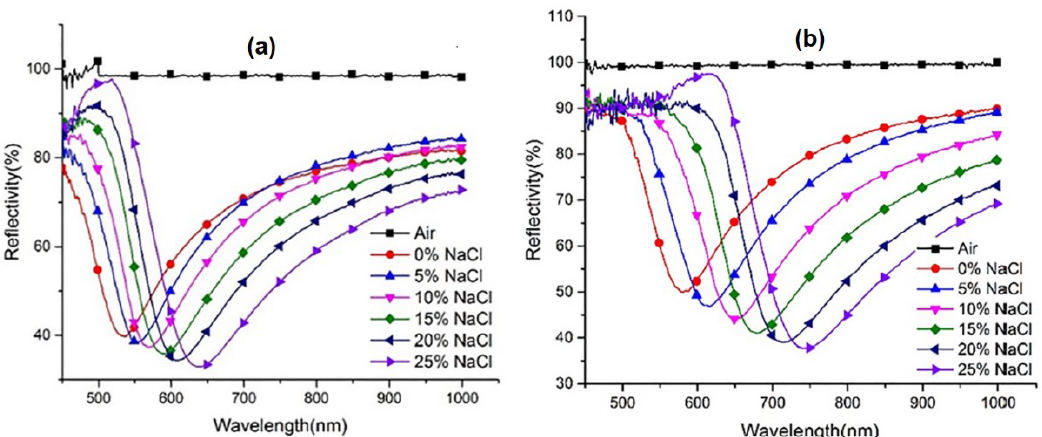
Figure 13. The SPR reflection spectrum at different concentrations of NaCl solution on sensing probes: ( a ) without graphene and ( b ) with graphene (adapted with permission from Reference [58], copyright Elsevier).